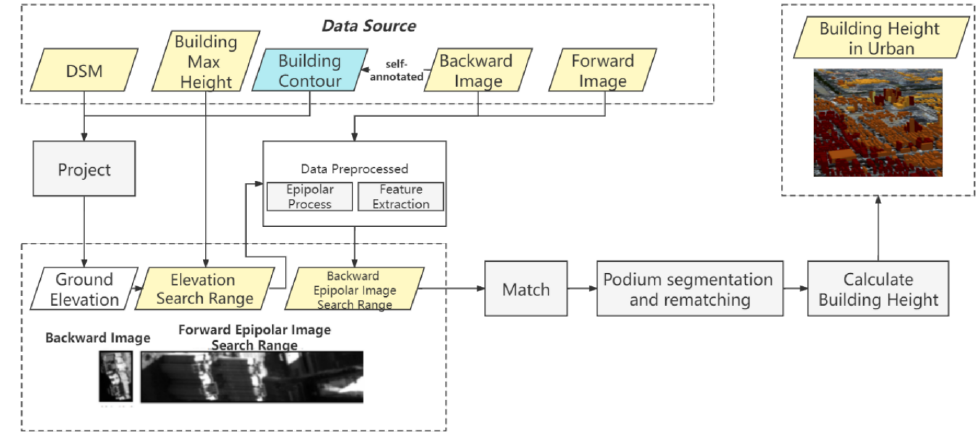
Figure 1. The overall workflow of the building height extraction